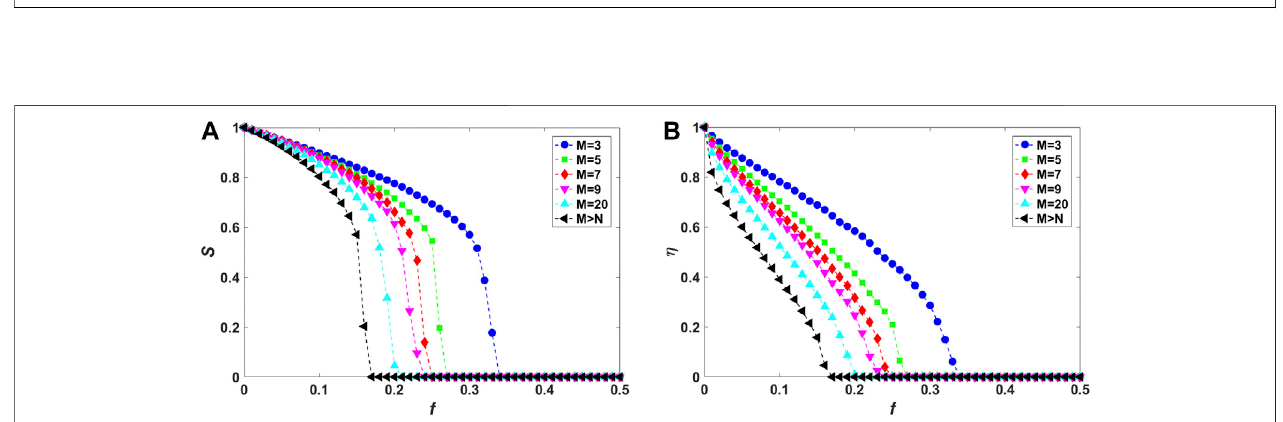
FIGURE 3 | (Color online) Vulnerability analysis of fully interdependent local-world networks (corresponding to interdependence strength q (cid:2) 1 . 0) after cascading failures caused by intentional removal of high-degree nodes from one network in the case of random interdependence. (A) Relative size S of the largest connected componentasafunctionofthefraction f ofremovednodes; (B) residualcommunicationef fi ciency η asafunctionofthefraction f ofremovednodes.Resultsareobtained by averaging over 50 independent realizations on interdependent systems consisting two local-world networks, which are separately constructed with N (cid:2) 2000, m (cid:2) 3, and 〈 k 〉 (cid:2) 2 m (cid:2) 6 for different M ( M (cid:2) 3 , 5 , 7 , 9 , 20 and M > N